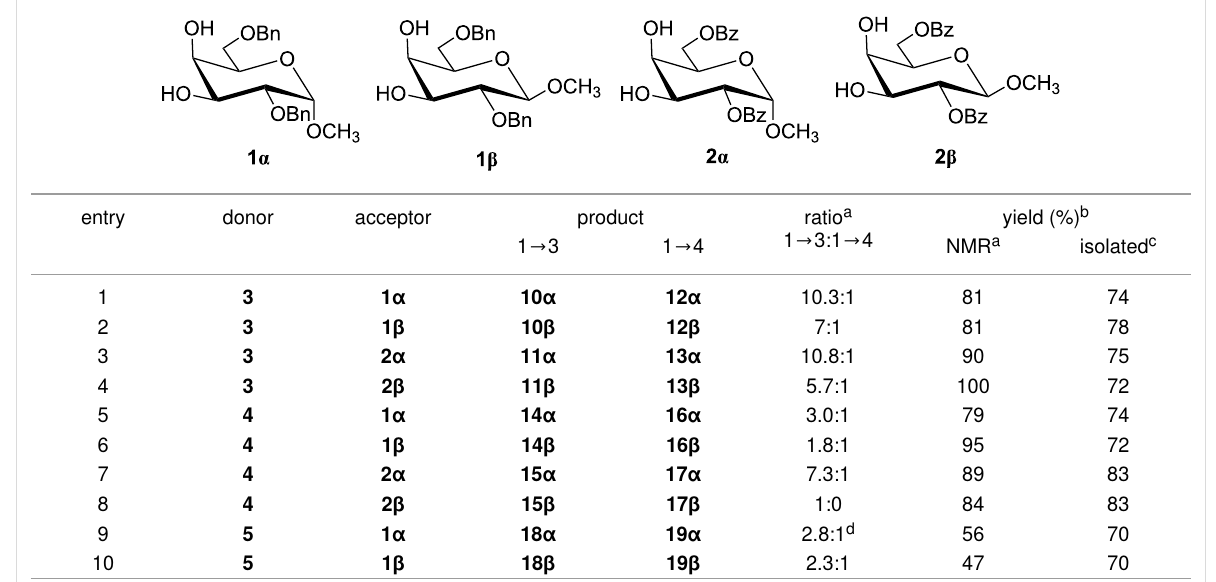
Table 1: Ratios and yields of 1 → 3 and 1 → 4 disaccharides obtained by reaction of donors 3 – 5 with acceptors 1 α / β and 2 α / β .